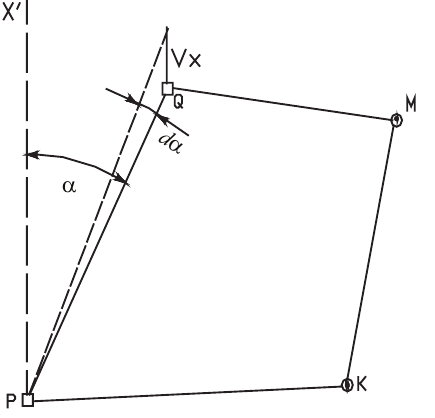
Fig. 2. Adjustment correction ν x of point Q brings about the change d α of the initial direction angle α PQ . Axis x ’ is parallel to x coordinate